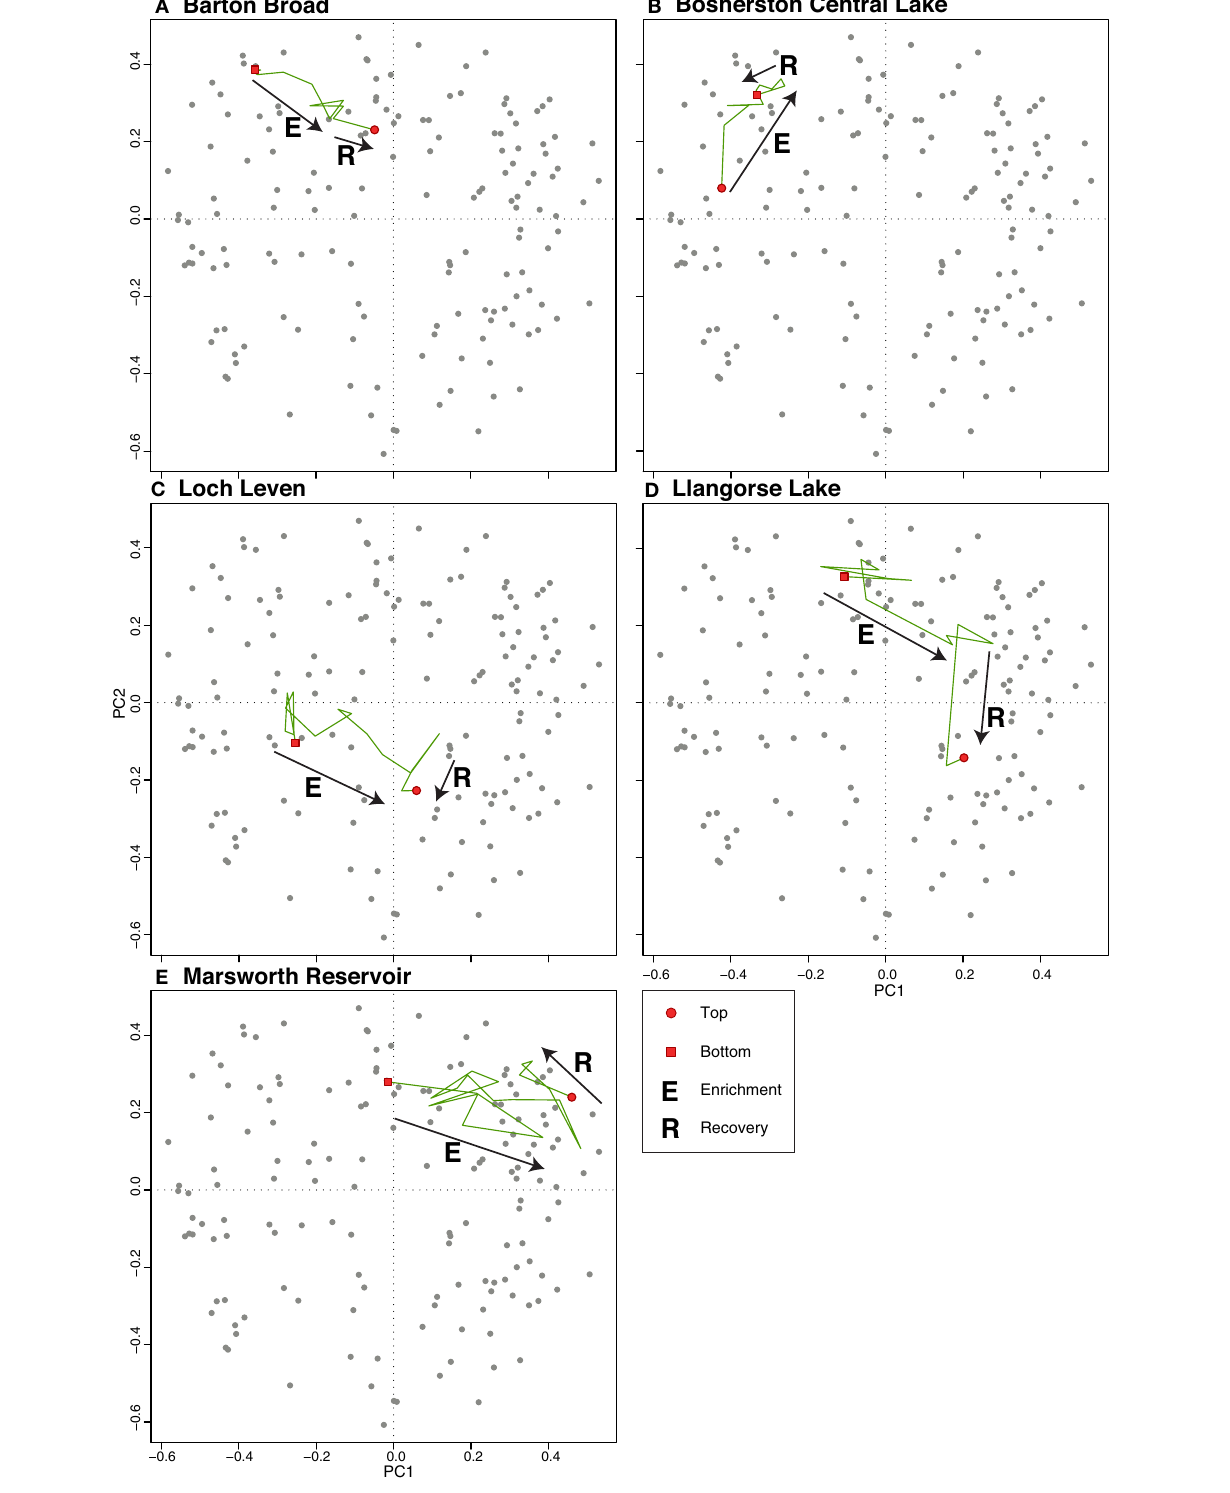
Frontiers in Ecology and Evolution |